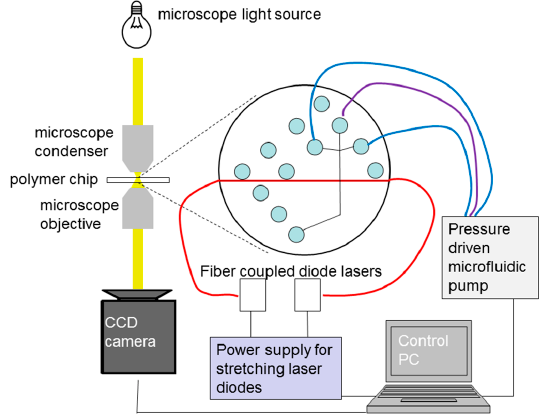
Figure 7. Schematic representation of the optical stretching setup.